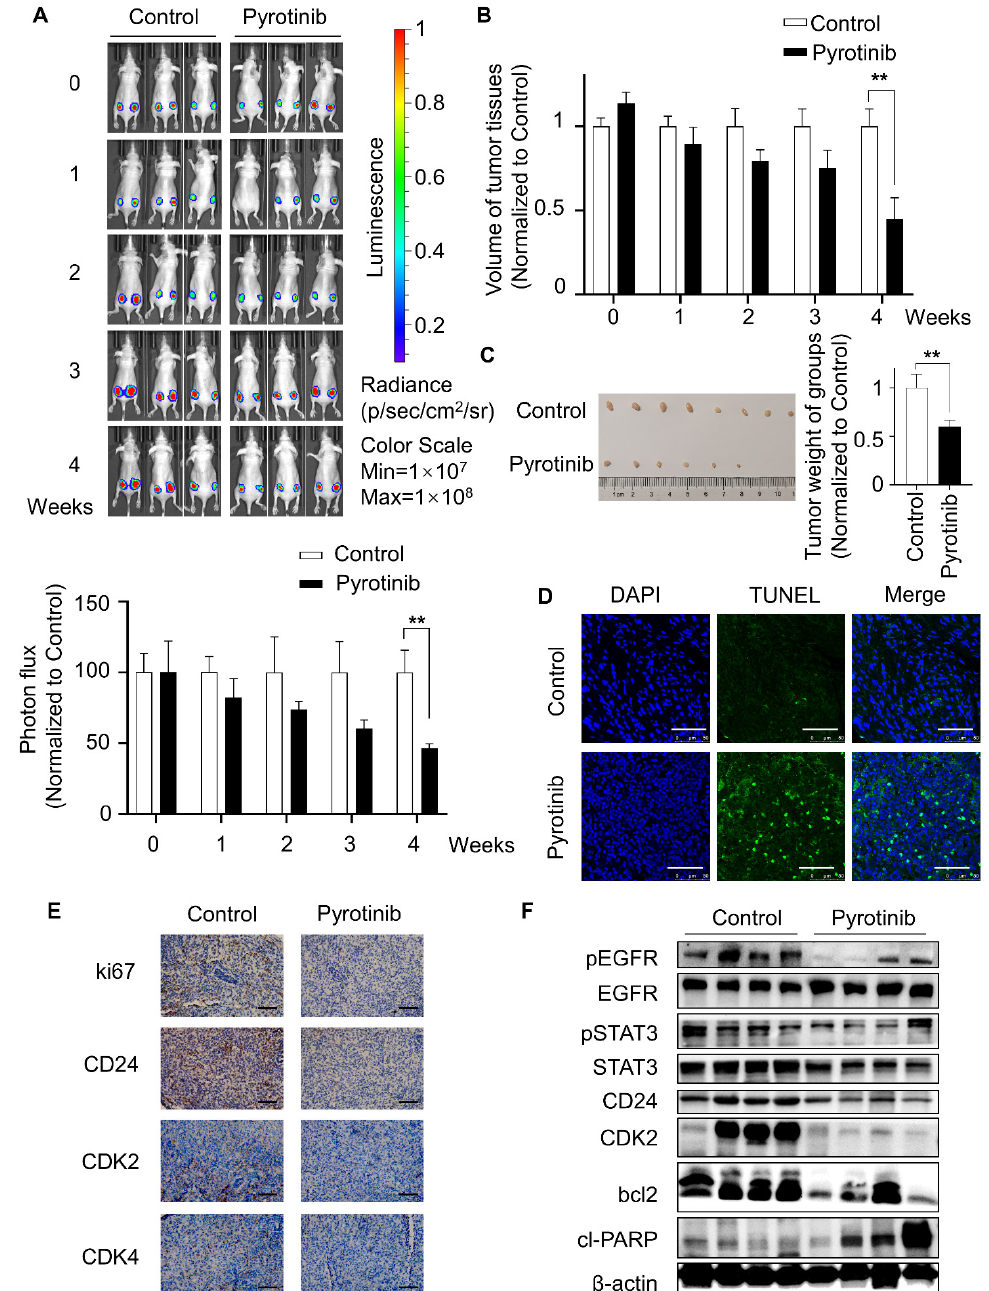
Figure 5. Pyrotinib impeded the viability of TSC2 deficient cells in vivo. ( A ) After subcutaneous injection of luciferase-expressing TSC2-deficient cells into female nude mice, pyrotinib (40 mg/kg)